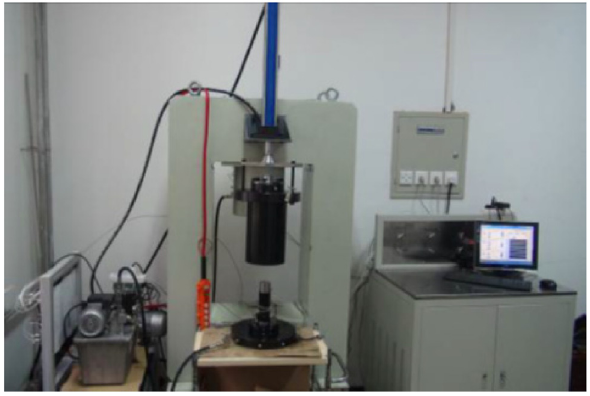
Figure 1: The image of the